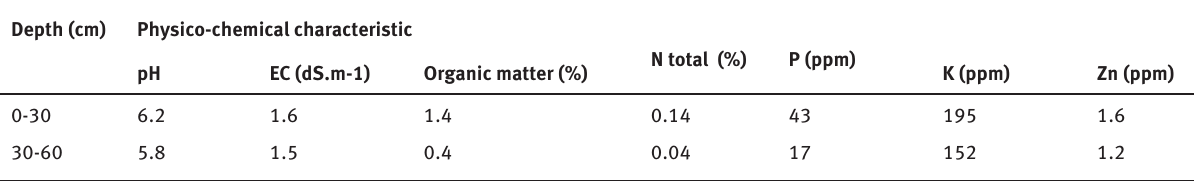
Table 1: Soil characteristics in shallow (0-30cm) and deep (30-60 cm) samples from the study orchard